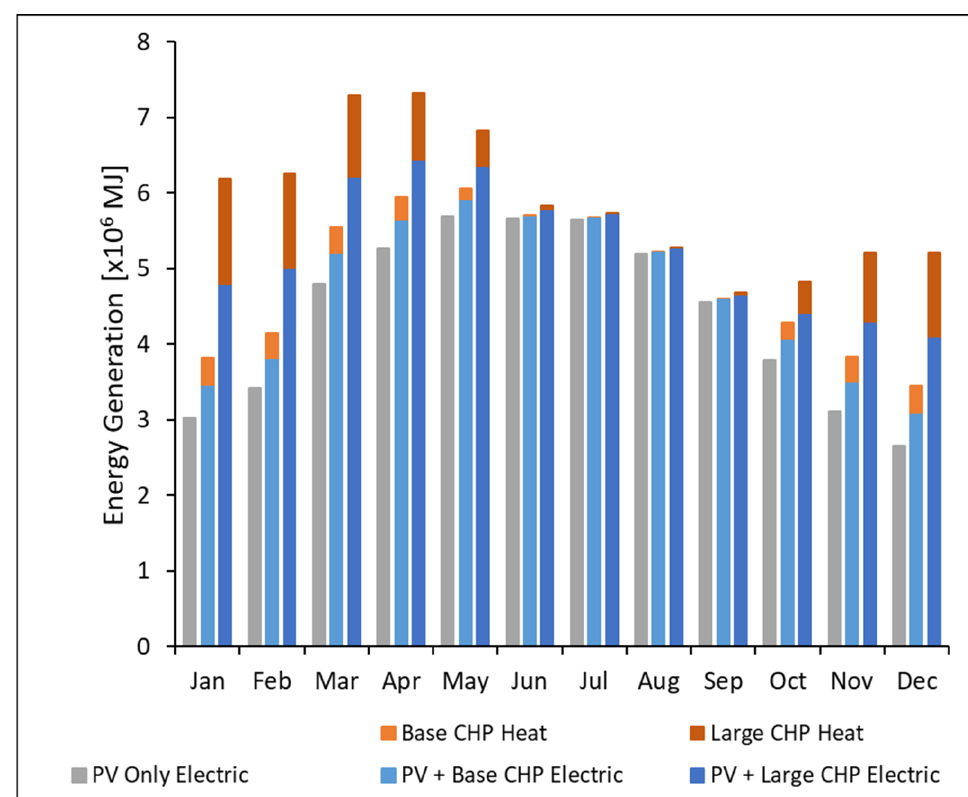
Figure 3. NWC Renewable Energy Generation by month. PV generation is the baseline for the campus and supplemented with either the base or large CHP technology. Heat energy is differentiated by color. CHP on/off duty operation is determined based on hourly heating load requirements. The resultant base CHP system operates at 72% of annual capacity. The large CHP is throttled in increments of 25% proportional to the 2× Summer heating load. The operational duty result is 55% of annual capacity. Table 1. NWC annual energy-generation capacity. Capacities are listed by renewable energy type and technology. Heat Pump (HP) is reported as a parenthesized negative electric generation, mean- ing that electric load increases, and a positive heat generation, meaning natural gas load is reduced. Thus, the total energy generation reported in the table is the energy load reduction compared to a non-HP scenario.